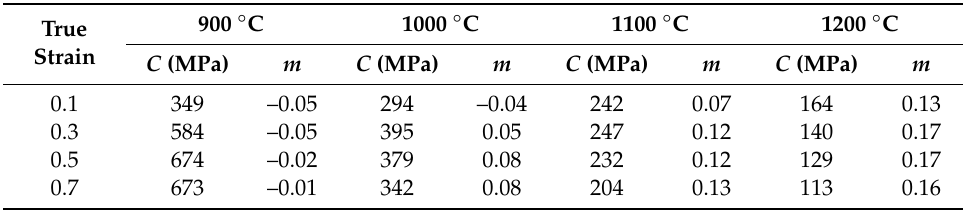
Table 1. Values of the strength coe ffi cient ( C ) and strain rate sensitivity ( m ) at di ff erent temperatures and true